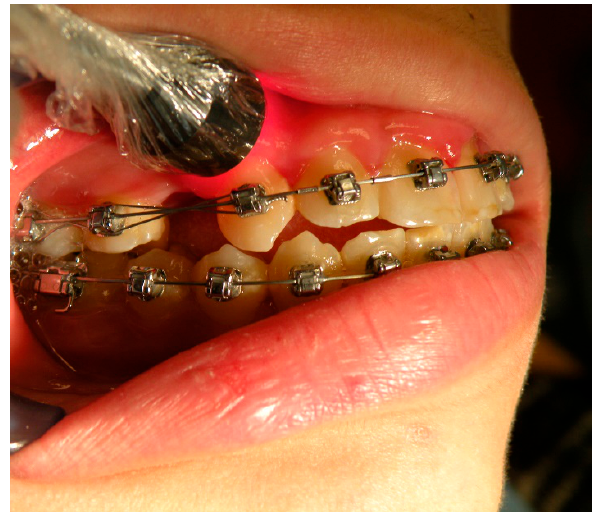
Figure 1. Vestibular view of the third cervical irradiation of an experimental canine.